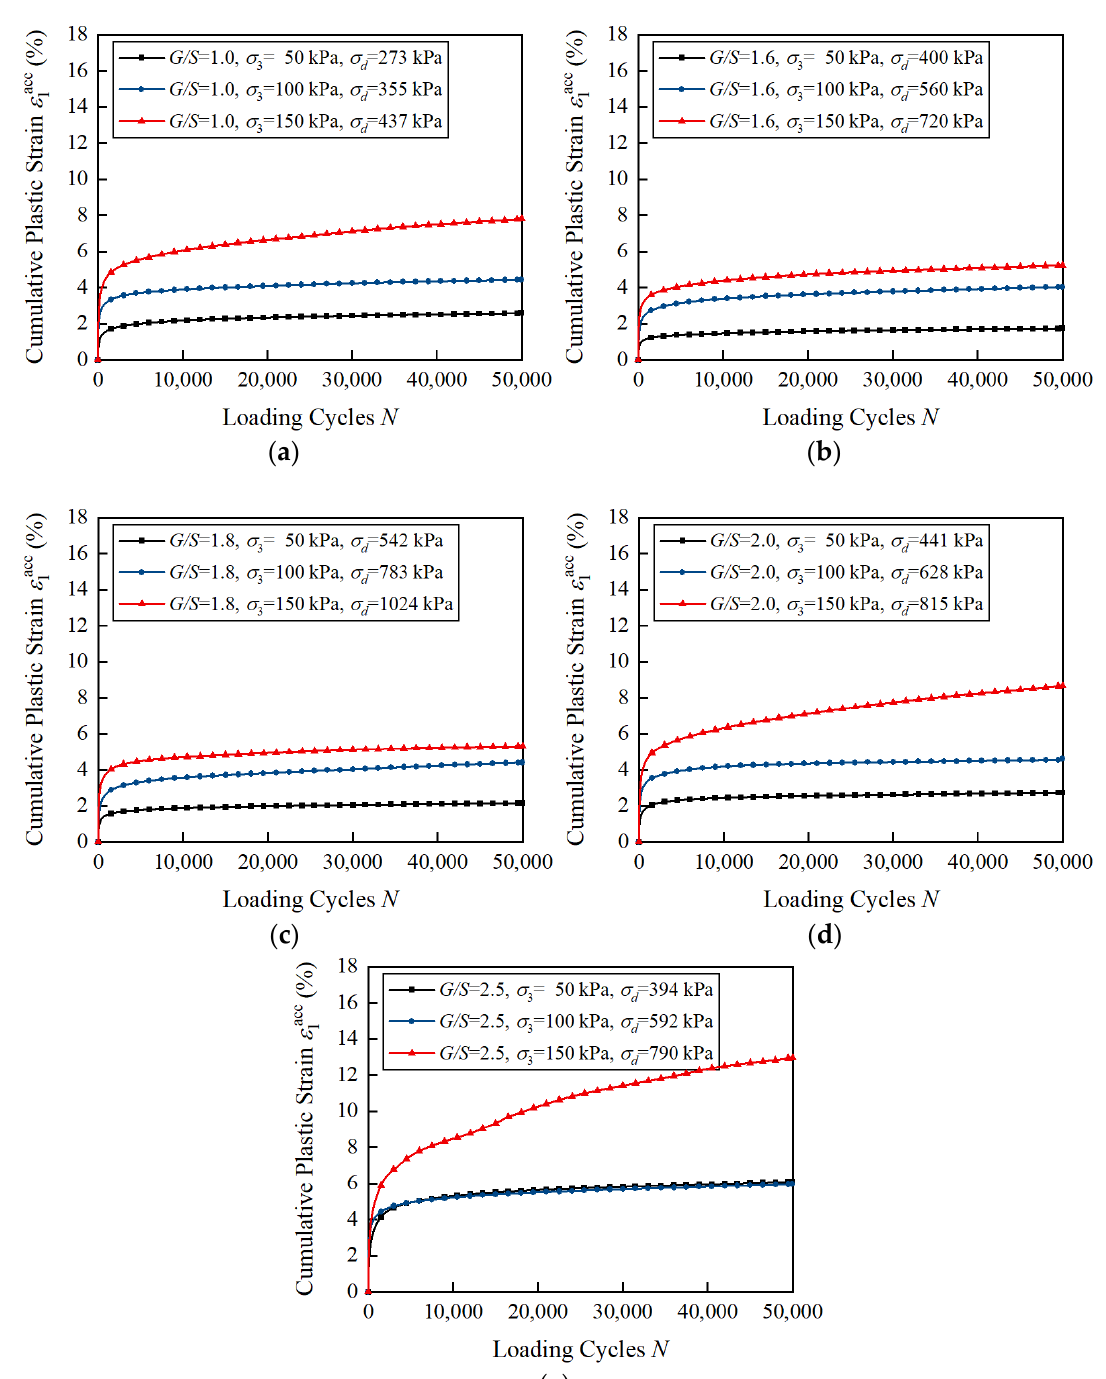
Figure 8. Laboratory-measured permanent deformation of unbound aggregate base materials with different G / S values under SSR = 0.9 and different confining pressure levels: ( a ) G / S = 1.0; ( b ) G / S = 1.6; ( c ) G / S = 1.8; ( d ) G / S = 2.0; ( e ) G / S = 2.5.